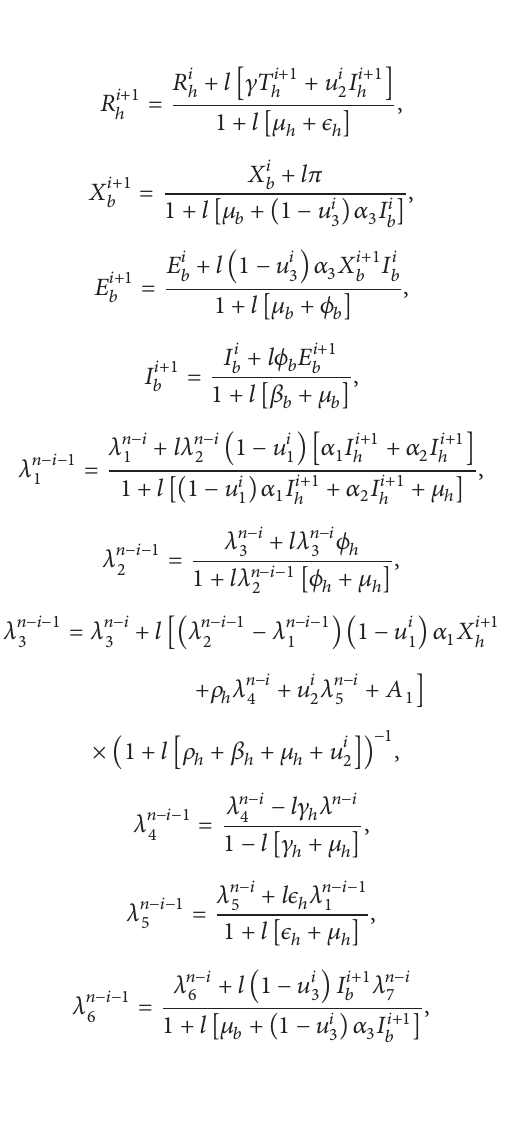
Figure 5: The plot represents the population of recovered humans with and without